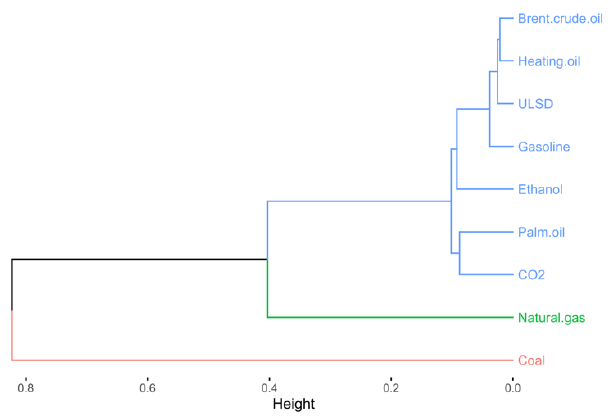
Figure 13. Dendrogram for hierarchical clustering of prices of commodities for the third subperiod. Source: own elaboration on the basis of data from www.stooq.com (accessed on 19 April 2021).